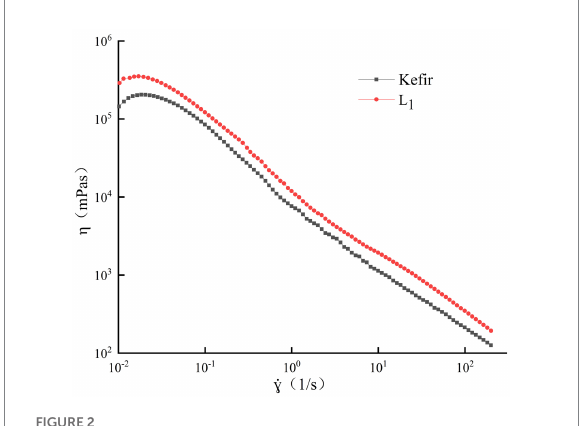
FIGURE 2 Analysis of rheological